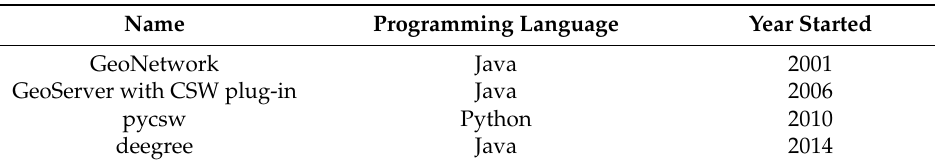
Table 1. CSW server implementations.